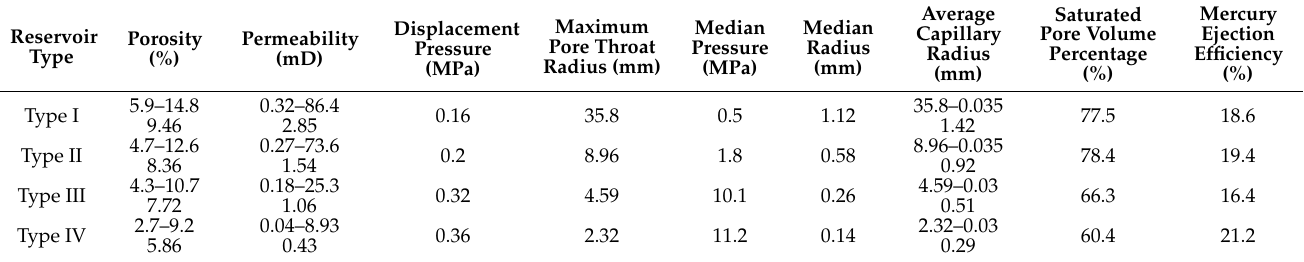
Table 4. Microscopic pore structure parameters of different